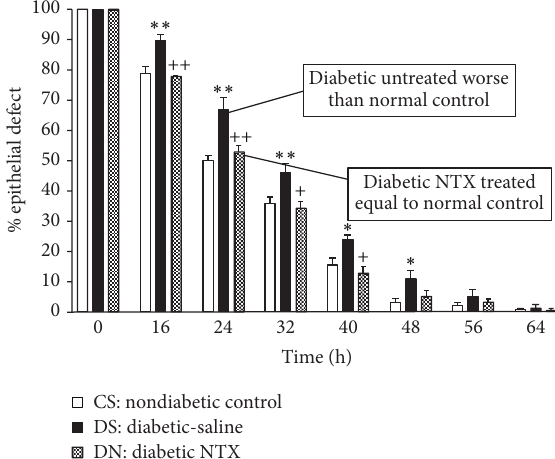
Figure 10: Naltrexone treatment normalizes epithelial wound healing in diabetic rats. Residual epithelial defect up to 64h after creation of a 5mm corneal abrasion. DS (untreated diabetic) had significantly larger residual epithelial defects than the CS (nondiabetic) or DN (NTX-treated diabetic rats). Therefore, NTX treatment prevents the delay in wound healing of ocular surface epithelium observed in poorly controlled diabetic animals. Data are expressed as means ± SEM and represent the residual of the original defects presented as a percentage of the original wounds. Significant difference between the DS and CS groups, ∗ 𝑃 < 0.05 or ∗∗ 𝑃 < 0.01 . Significant difference between the DS and DN groups, + 𝑃 < 0.05 or ++ 𝑃 < 0.01 (derived from